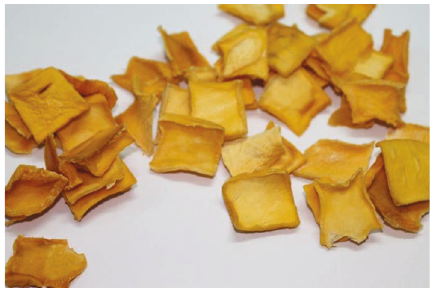
Figure 6: Dried mango